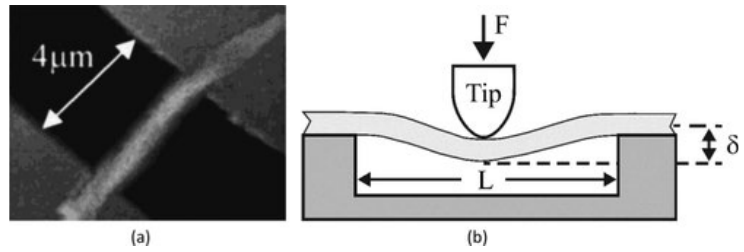
Figure 18. ( a ) Single-electrospun nanofiber suspended over etched grooves of silicon wafer, and